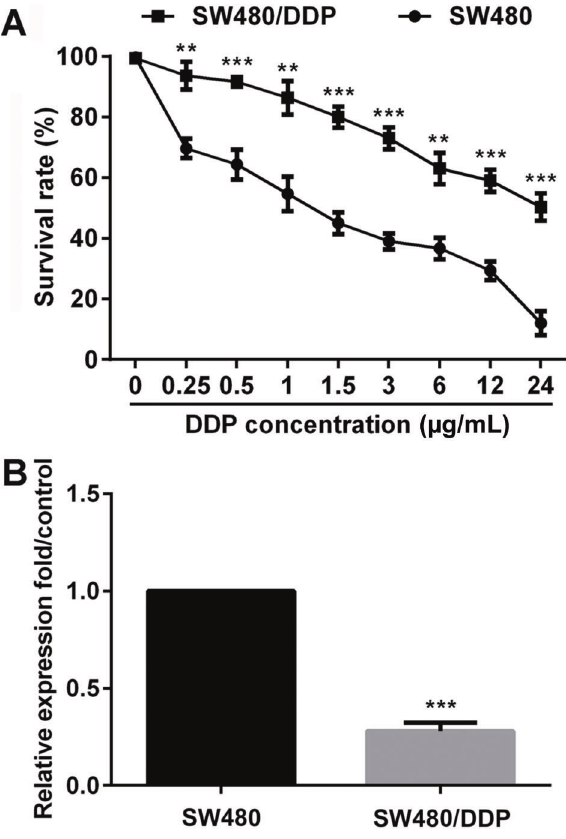
Figure 2. Effects of LINC00261 on acquired resistance to cisplatin. The survival rate of cell lines exposed to different concentrations of cisplatin (cis-diammineplatinum dichloride, DDP) was analyzed to con fi rm the drug-resistance ef fi ciency